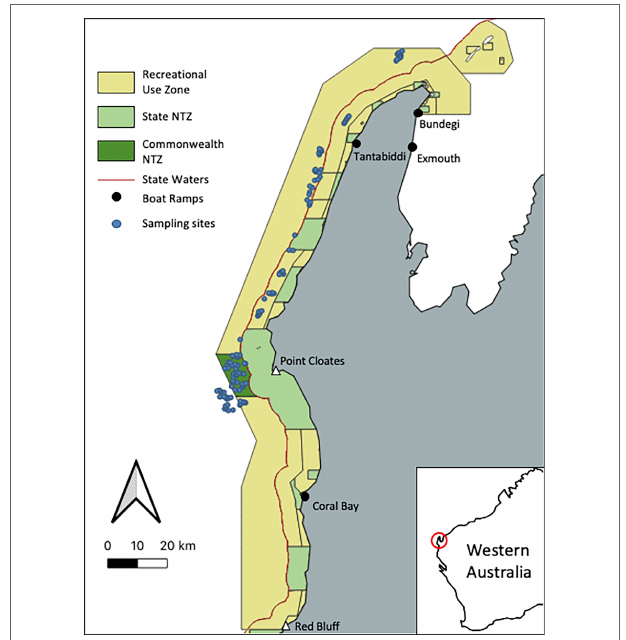
FIGURE 1 | Map of sampling design for the NMP-Commonwealth showing the location of the 122 sampling points (blue dots), the no-take zone and the recreational use zone where recreational fishing is permitted. The black dots indicate boat ramps likely to be used by recreational fishers for access to the